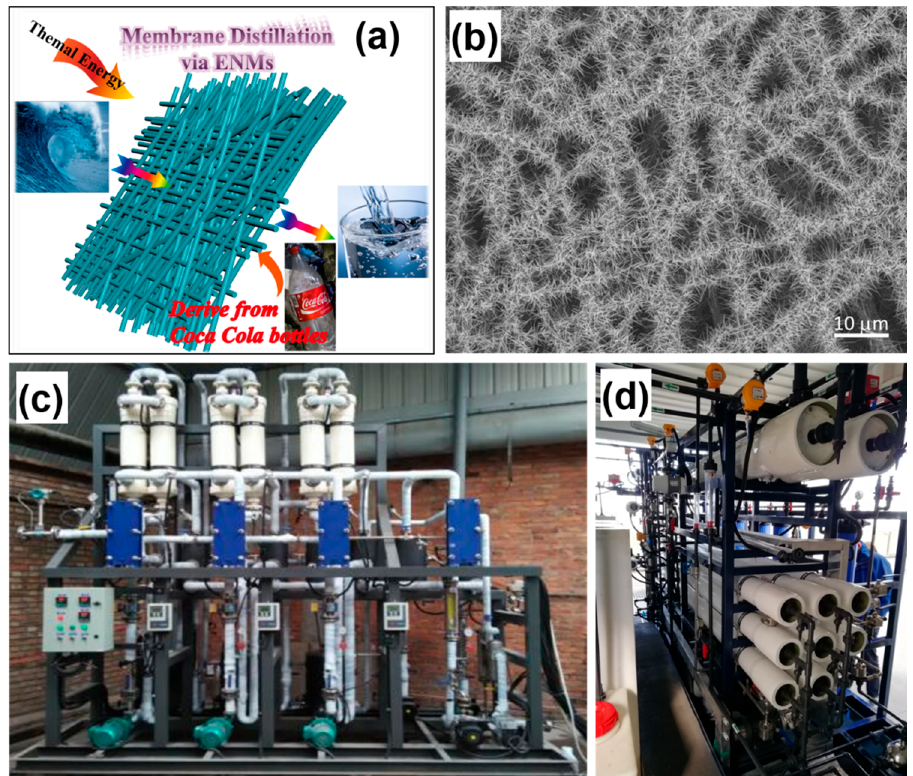
Figure 13. ( a ) A brief illustration of MD membranes based on the electrospun nanofibrous mem- branes derived from Coca Cola bottles [59]. ( b ) SEM image of the hierarchical nanostructures on nanofibrous membranes (unpublished work). ( c ) Three-effect MD pilot equipment with a capacity of 2 m 3 /d. ( d ) A hybrid FO-MD system.